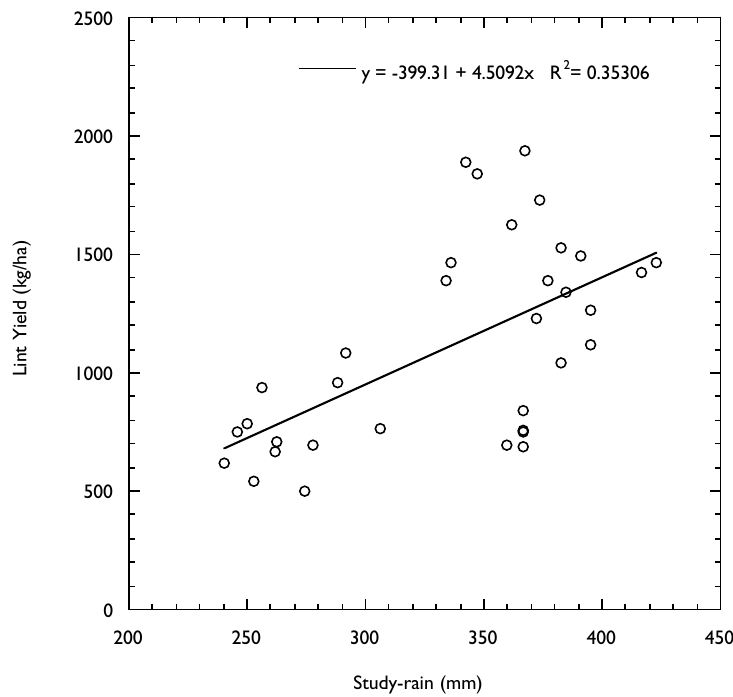
Figure 9. The lint yield as a function of the study-rain (rain + simulated rain) for four plantings in 2016 and seven plantings in 2017 with four rain simulations in each planting. R 2 = 0.35.